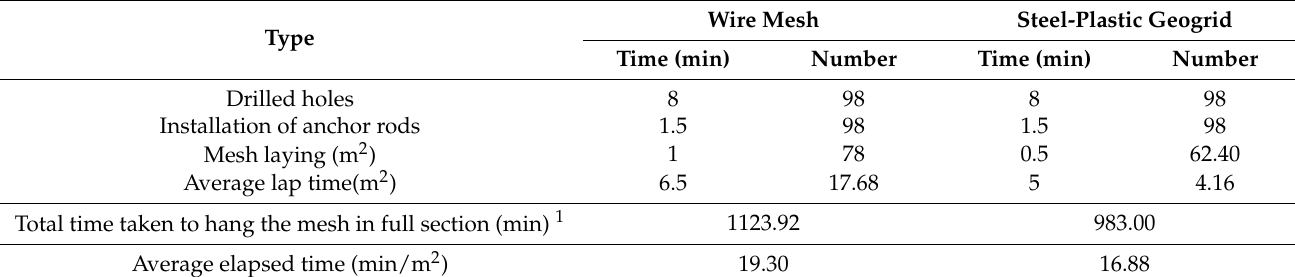
Table 6. Statistics on the time required for the construction of the site